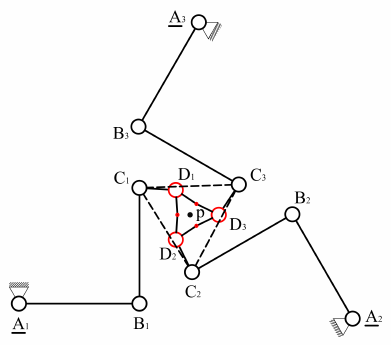
Figure 13. Equivalent kinematics model based on two simplified conditions